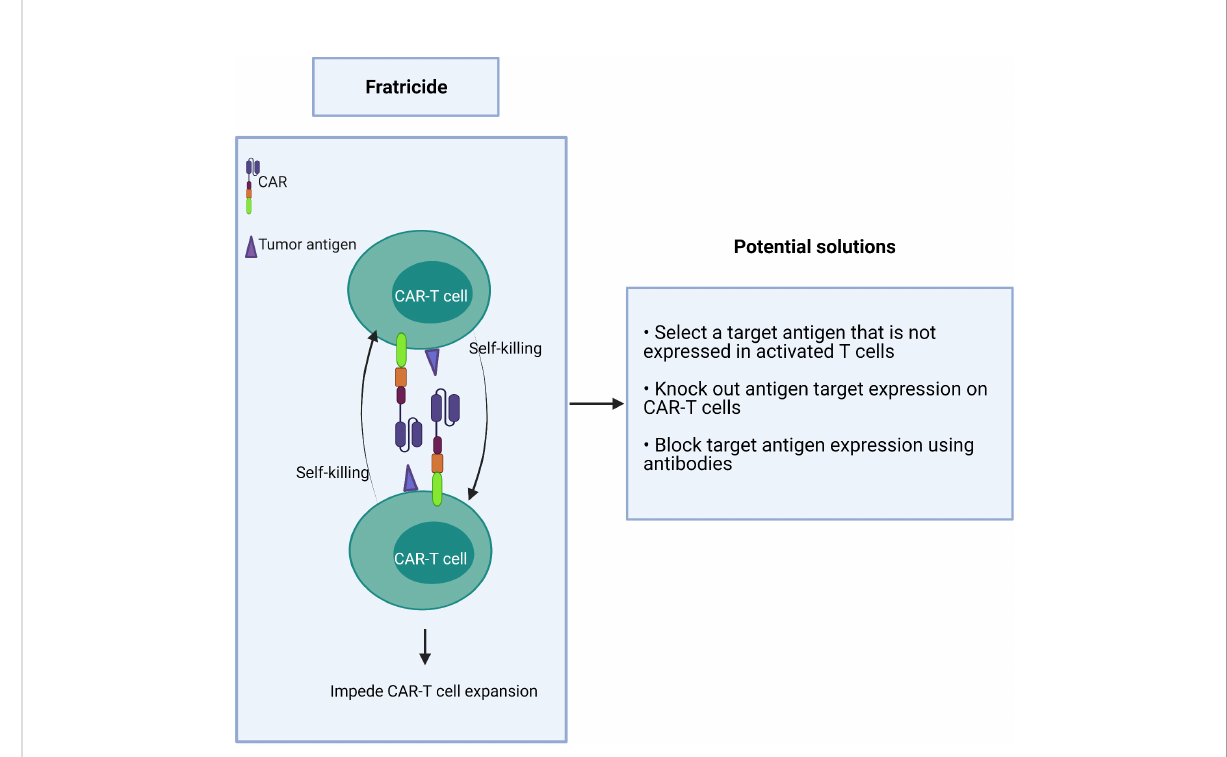
FIGURE 4 Fratricide between CAR-T cells greatly impedes expansion of the therapeutic